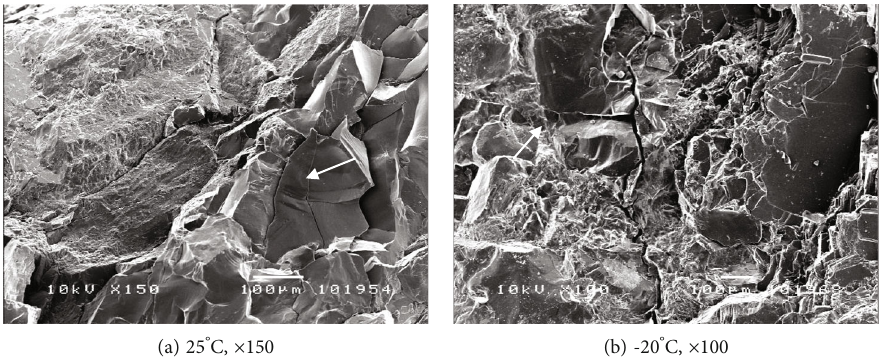
Figure 13: Secondary crack. Lamellar tearing fracture